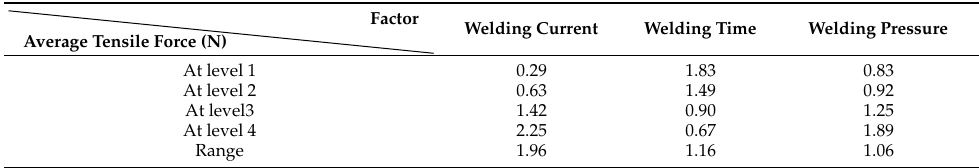
Table 2. Range analysis of the orthogonal experiments.